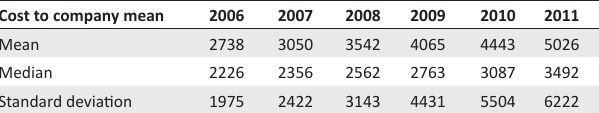
margin mean is regressed on the guaranteed CTC mean. A low r ² is indicated. Figure 11 indicates the regression of the AT mean on the guaranteed CTC mean. A higher r ² is achieved and the same negative relationship appears as with the first two constructs.